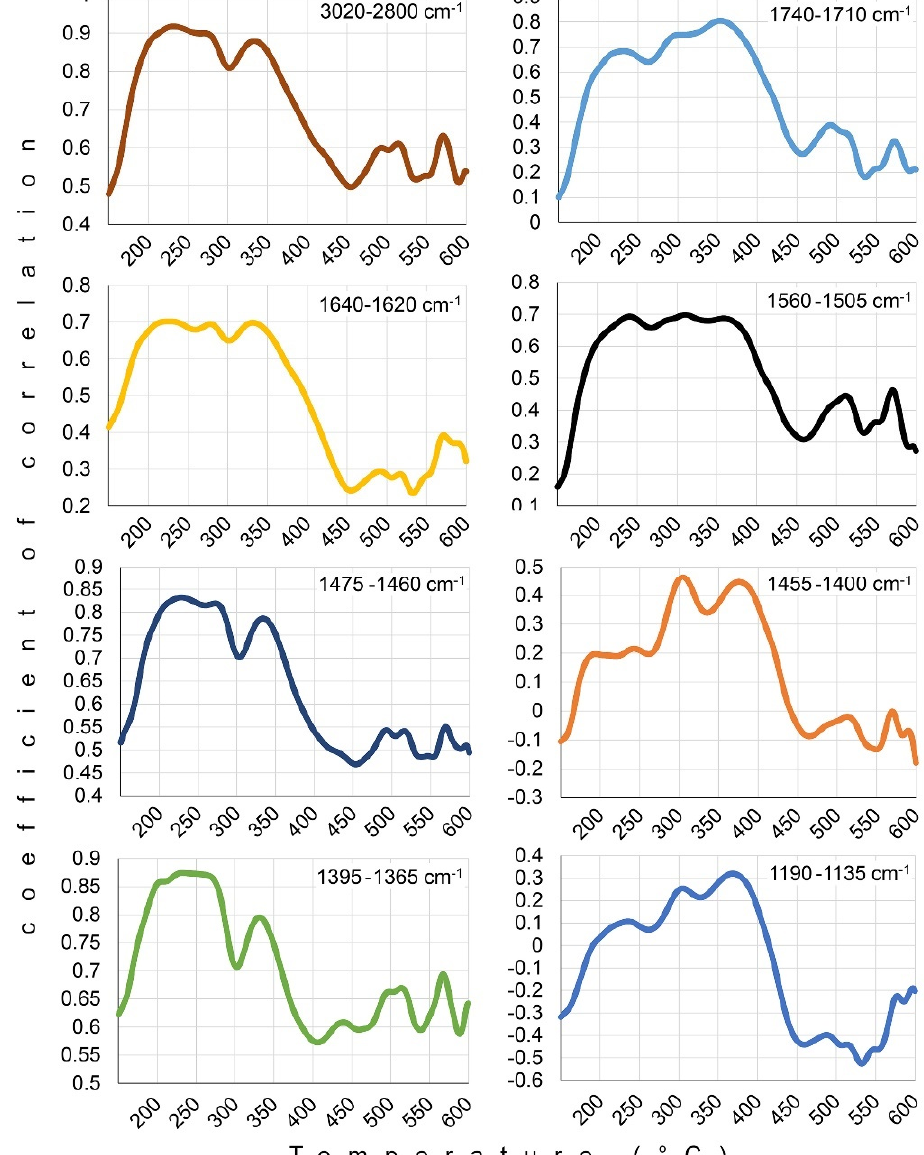
Figure 5. Correlations (Pearson’s) between FTIR peak areas and the rate of weight loss (DTG) recorded in 150 and 500 ◦ C interval (0.29; 0.38; 0.47 values correspond to p < 0.05; 0.01; and 0.001 significance level).